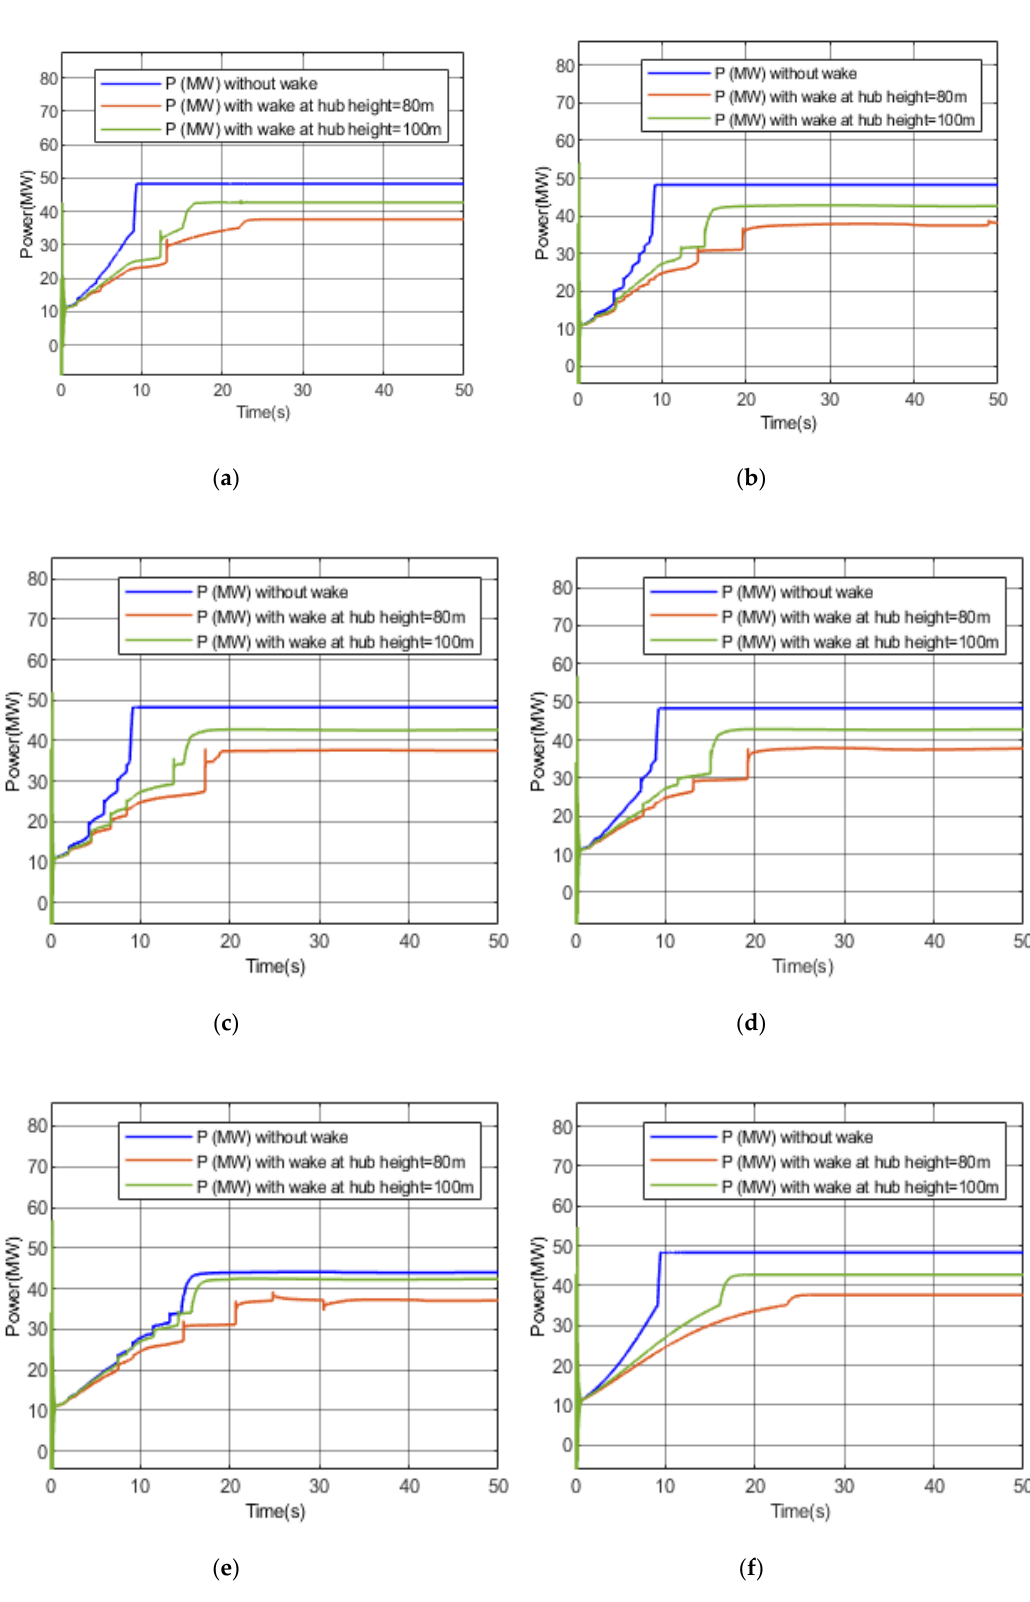
Figure 14. Special case P profiles: ( a ) P in Ideal case; ( b ) P with capacitor bank; ( c ) P with SVC; ( d ) P with STATCOM; ( e ) P with SSSC; and ( f ) P with